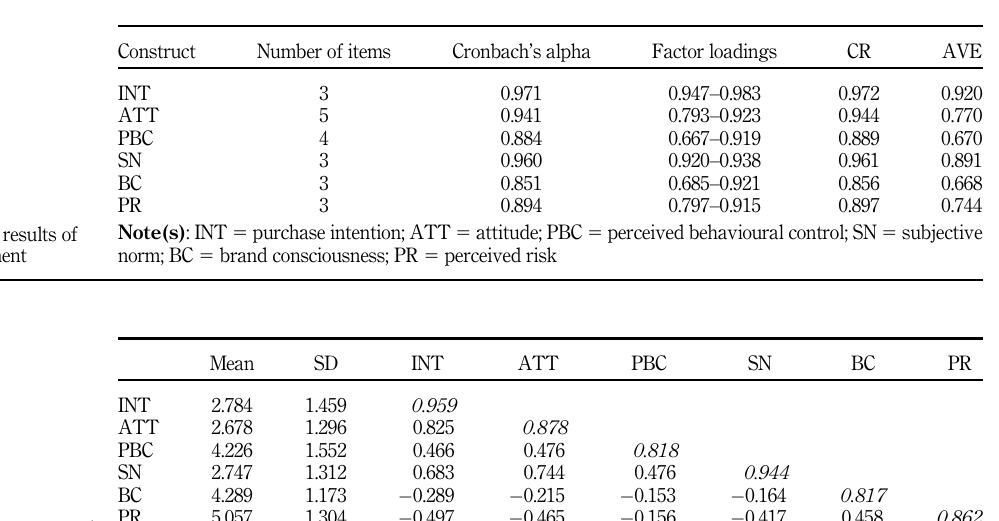
Table 3. Mean, SD, square roots of AVE and correlations between